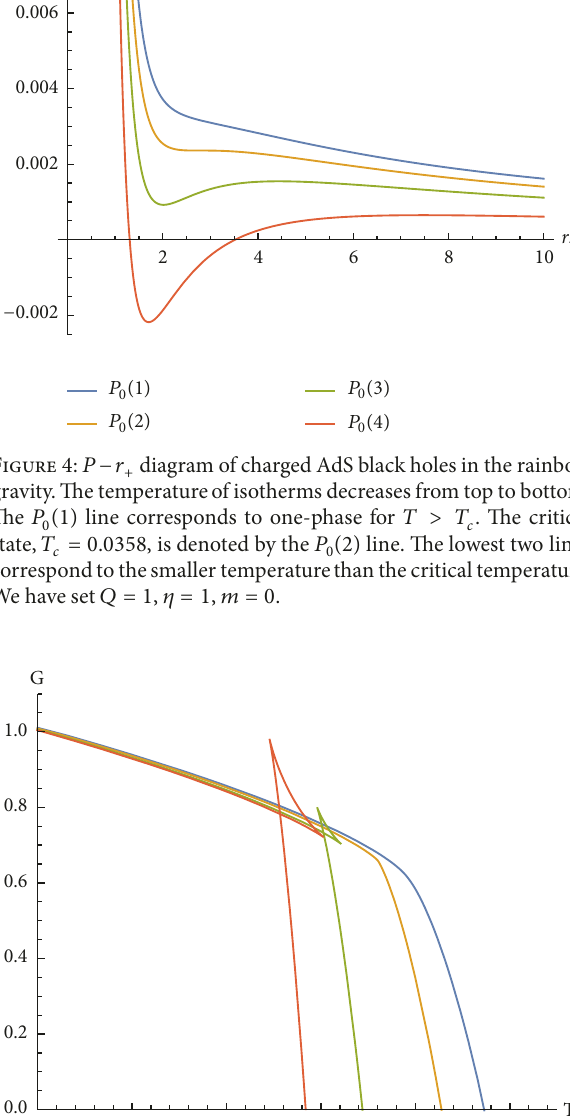
temperature, and radius. At last, we have discussed the Gibbs free energy and have obtained characteristic “swallow tail” behaviour which can be the explanation of first-order phase